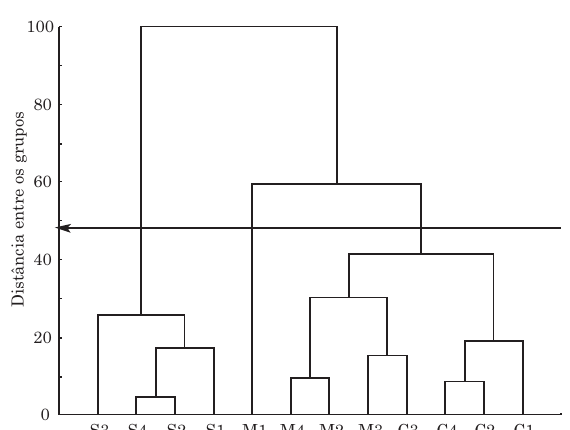
Figura 6. Dissimilaridade entre os grupos estabelecida por distância euclidiana a partir dos atributos argila, areia, silte, grau de floculação; porcentagem de agregados estáveis na classe (2,0- 4,76 mm); diâmetro médio ponderado; matéria orgânica; densidade do solo; resistência à penetração. C1, C2, C3 e C4 correspondem ao sistema de cultivo de mamoeiro sob camalhão; S1, S2, S3 e S4, ao sistema de cultivo de mamoeiro sob sulco; e M1, M2, M3 e M4, à mata nativa secundária, todos, respectivamente, às camadas de 0,0-0,1; 0,1-0,2; 0,2-0,3 e 0,0-0,3